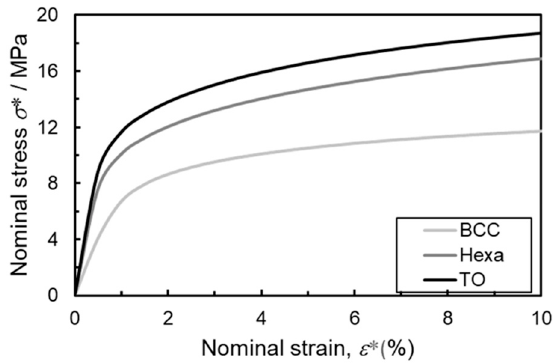
Figure 12. Stress-strain curves for lattice models consisting of the BCC, TO and Hexa unit cells calculated by the FEM analysis.